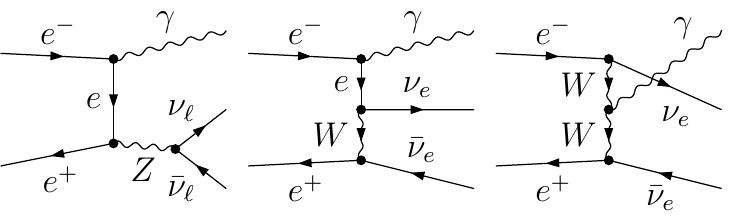
Figure 3 . Leading order e + e (cid:0) ! (cid:23) (cid:22) (cid:23)(cid:13) processes at CEPC. The W -boson can mediate the e + e (cid:0) ! (cid:23) e (cid:22) (cid:23) e (cid:13) processes; the Z -boson diagrams contribute to all neutrino (cid:13)avors.